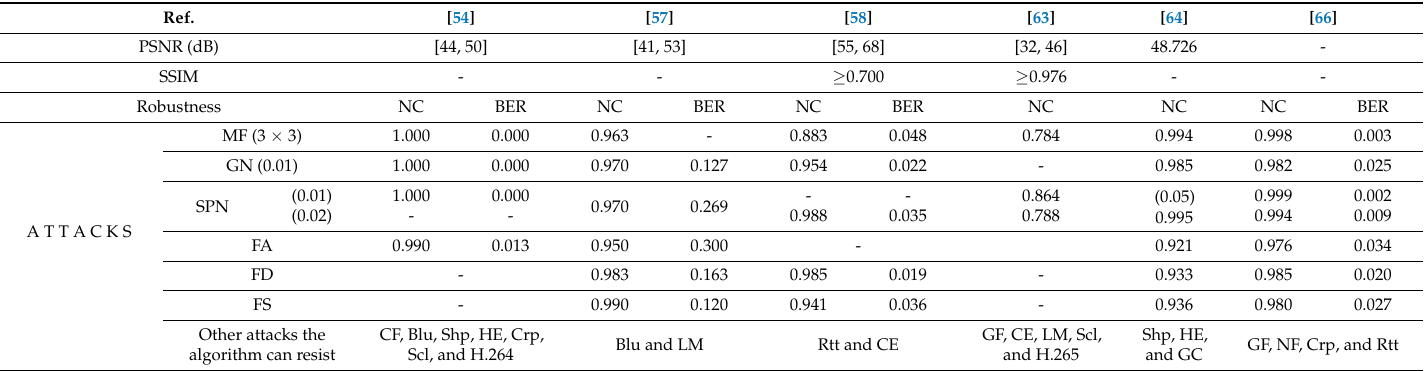
Table 8. Quantitative comparison of invisibility and robustness of several typical algorithms in hybrid domain.